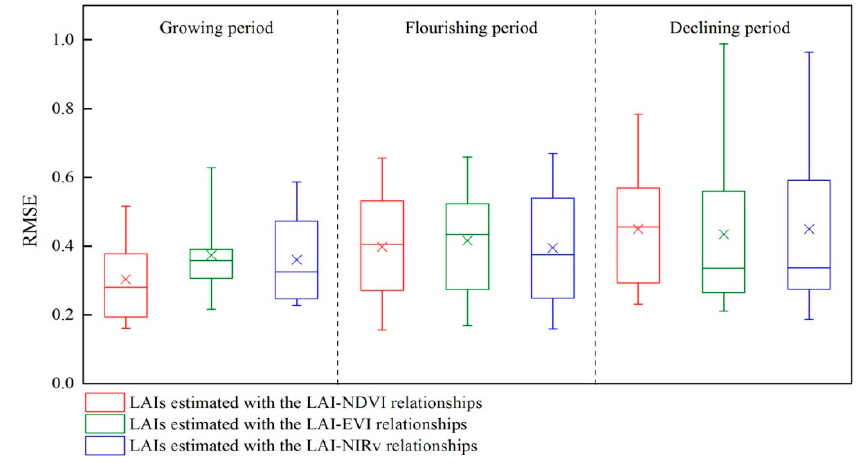
Figure 5. The RMSEs of the LAIs estimated with the three LAI-VI relationships for different phenophases. See Figure 2 for descriptions of the boxplot.